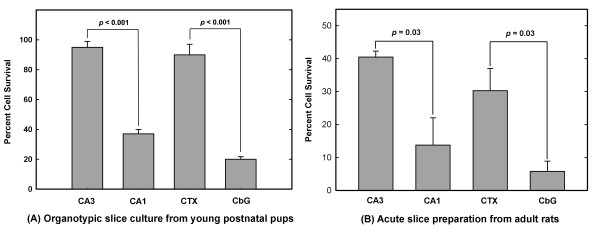
Selective vulnerability of hippocampal CA1 and CbG neurons as compared with CA3 and CTX neurons in organotypic brain slice cultures and in acute slice preparations. Both organotypic brain slice cultures and acute slice preparations were treated with paraquat (100 μM, 1 h). Cell survival was determined by PI labeling. Data represent the mean ± SEM. The number of experiments were n = 6 for (A) and n = 3 for (B). Statistically significant differences (t-test) are shown for the indicated comparisons.